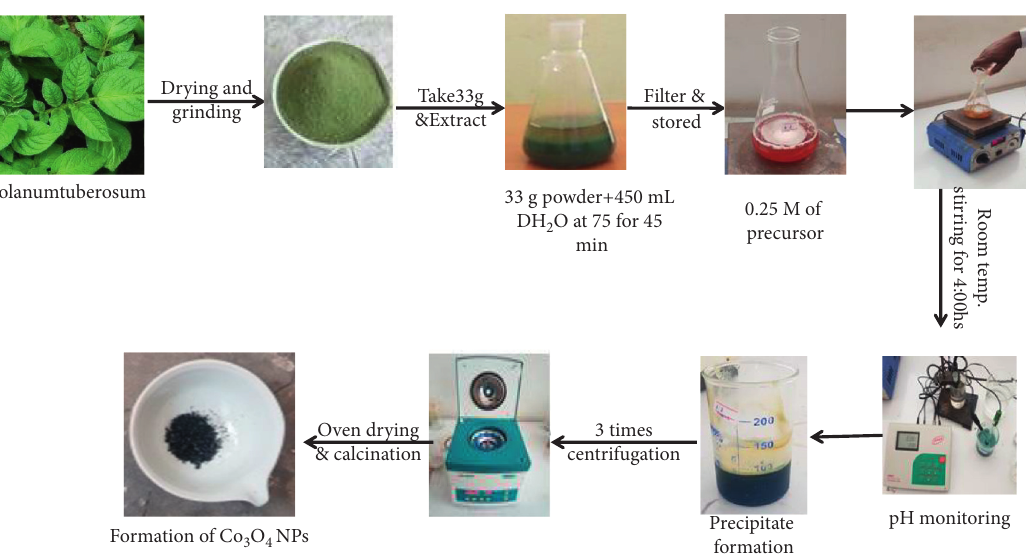
Figure 1: Diagrammatical biogenic synthesis of Co